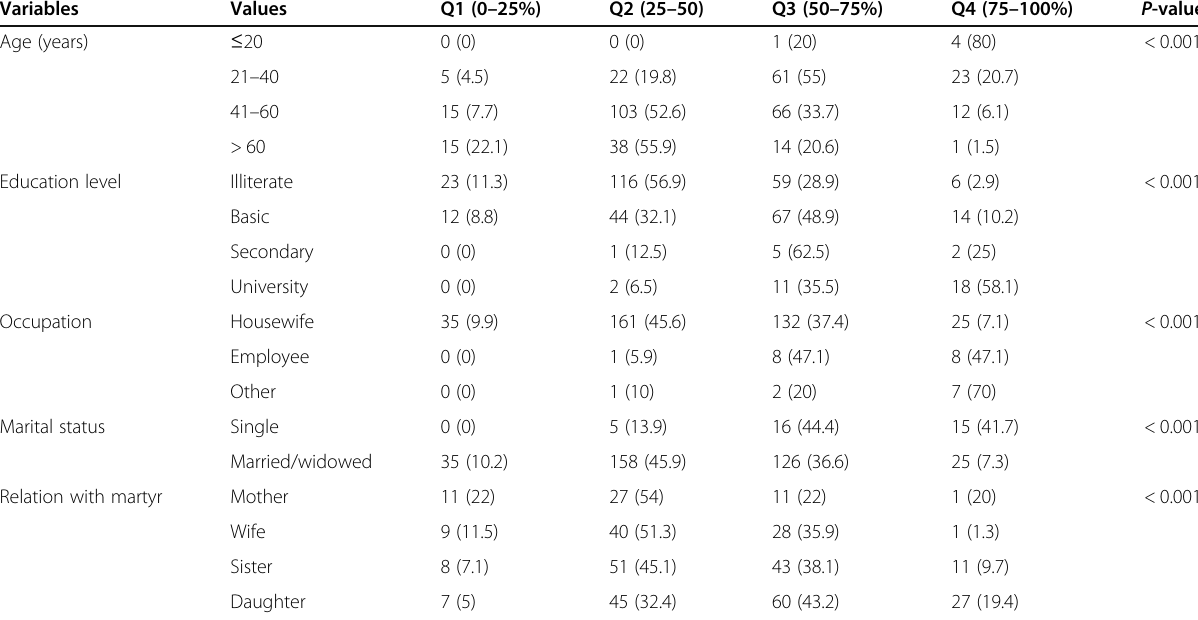
Table 3 Association between total QOL of the study sample with their socio-demographic characteristics